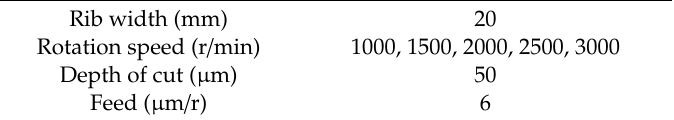
Table 7. Machining condition of micro cutting to optimize the rotation speed.